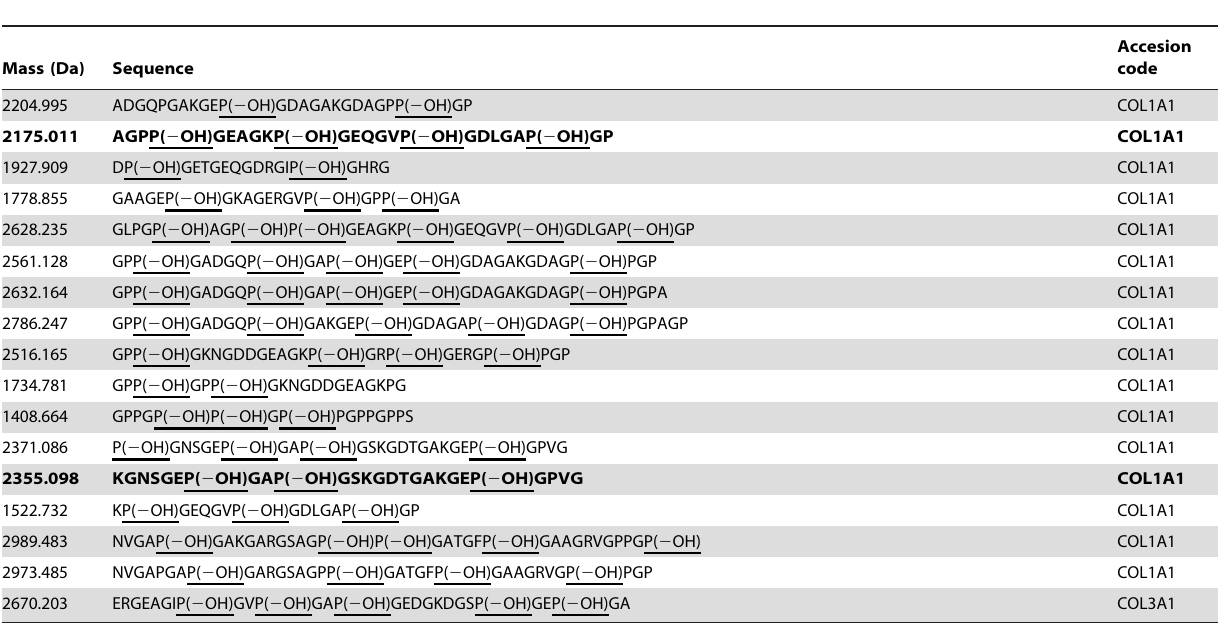
Table 3. Sequences of the 17 Peptides used for the first model in the discovery